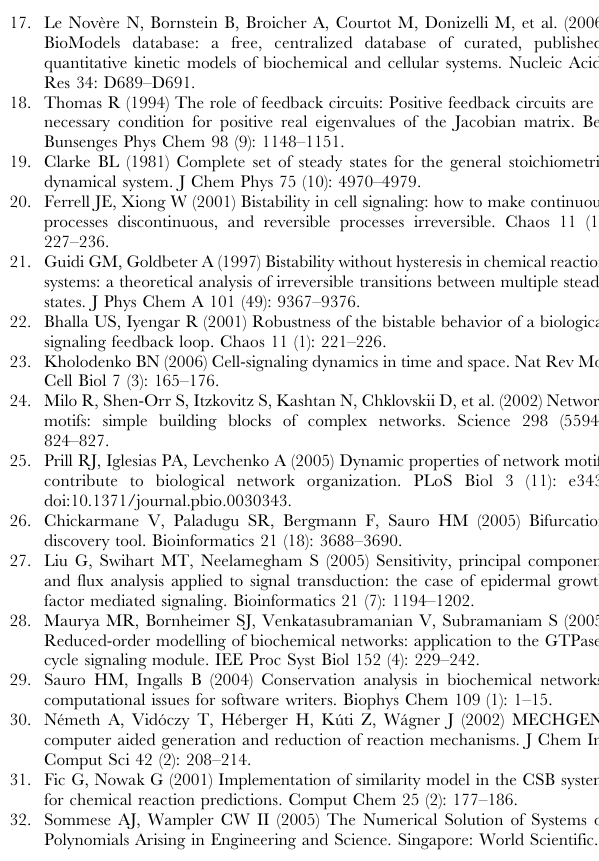
Figure S1. Minimum Spanning Tree (A) and Banyan Tree Graph (B). (A) Minimum spanning tree derived from high propensity configurations (rooted at 3 6 3M445). Inner nodes with smaller reaction sizes are drawn as larger circles. Four levels of the giant component are shown that shrinks but remains connected as the propensity threshold is raised. Dark blue is the range 0 , propensity , 0.1, white is propensity $ 0.3. (B) ‘‘Banyan tree’’ graph of nonautocatalytic models, with a few orphan systems. Color scale indicates propensity of configurations.